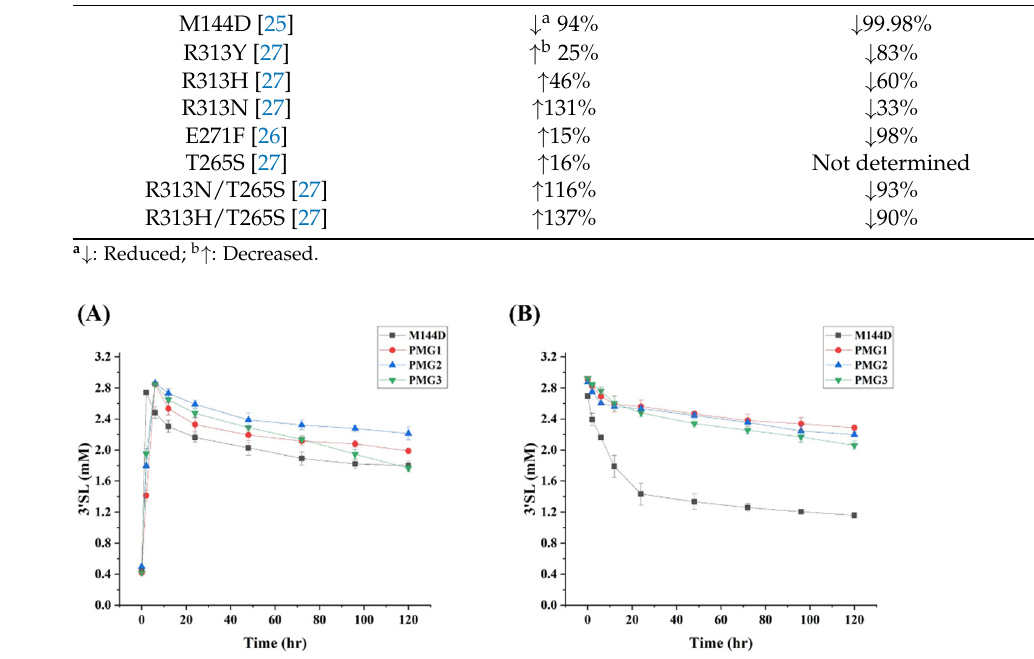
Figure 4. Comparison of α 2,3-sialyltransferase ( A ) and α 2,3-sialidase ( B ) activities of M144D, PMG1, PMG2 and PMG3. For the α 2,3-sialyltransferase activity assay, the reaction mixture (800 µ L) containing Tris-HCl (100 mM, pH = 8.5), 20 mM MgCl 2 , 3 mM lactose, 3.6 mM Neu5Ac and 3.6 mM CTP was incubated with NmCSS (0.2 mg/mL) and a variant enzyme (0.25 mg/mL) at 37 °C for different periods. For the α 2,3-sialidase activity assay, the reaction mixture (800 μ L) containing MES buffer (100 mM, pH = 5.5) and 20 mM MgCl 2 was incubated with 3 mM 3 ′ -SL, a variant enzyme (2.5 mg/mL), at 37 °C for different periods. At different time points, 25 μ L of the sample was transferred into an Eppendorf tube, and 25 μ L cold ethanol was added. The mixture was kept at 4 °C for 30 min, then centrifuged at 12,000 rpm for 10 min and the precipitates were removed. The supernatants were used for analysis. All reactions were done in triplicate.